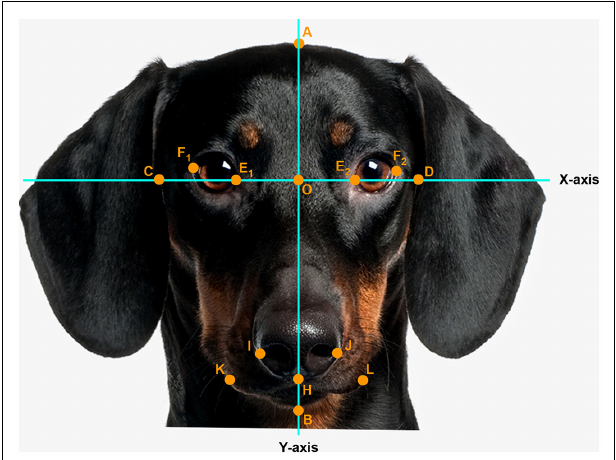
FIGURE 1 | Facial landmark (example: portrait of an adult dog). Head length (AB, fixed, 600 pixels), face width (CD), forehead length (AO), eye width (EF, as the average calculated from the right, E 1 F 1 and left E 2 F 2 eye width), nose length (OH), nose width (IJ), mouth width (KL). Photo: Thinkstock/Getty Images